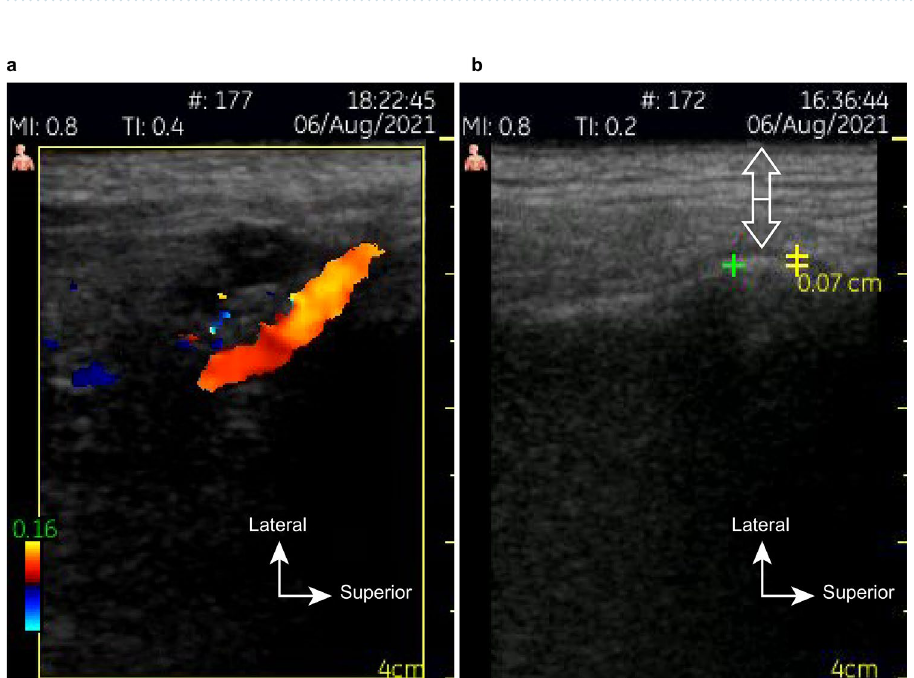
Figure 3. US images showing ( a ) the superficial temporal artery and ( b ) the soft tissue measurements (white arrows) and lateral joint spaces